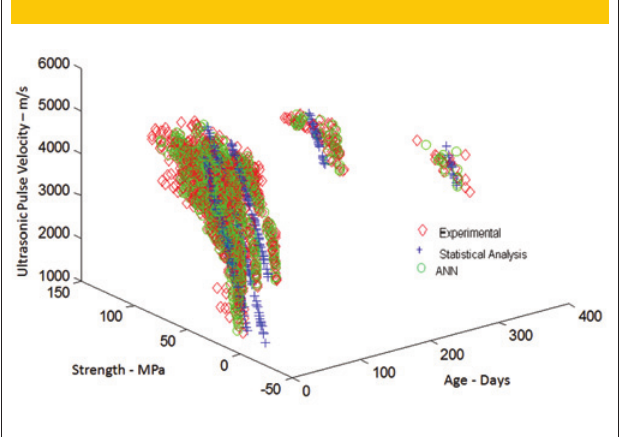
Figure 25 – UPV x fc x Age relationship – network 7x8x20x20x1 – Test data set